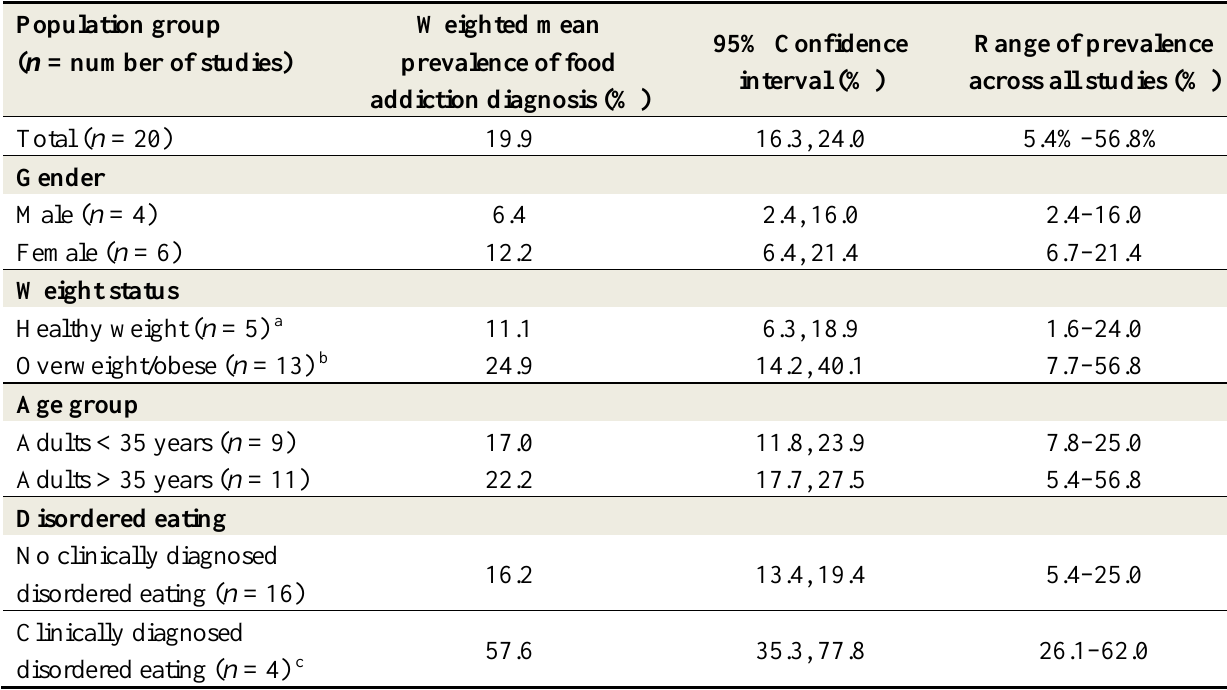
Table 4. Meta-analysis results of food addiction prevalence by gender, weight status, age, and disordered eating status. Random effects model is